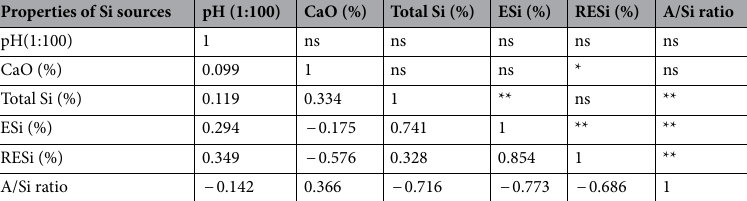
Properties of Si